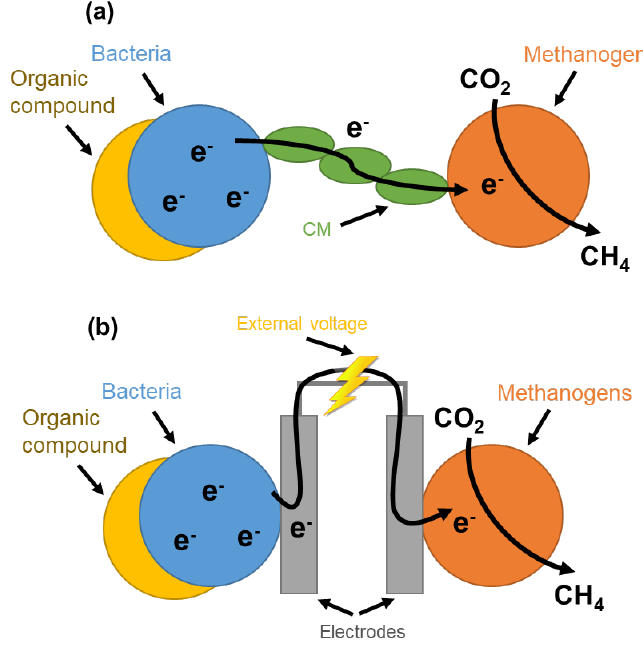
Figure 2. DIET stimulation mechanisms through ( a ) supplementation of conductive material (CM) and ( b ) applying external voltage (EV).